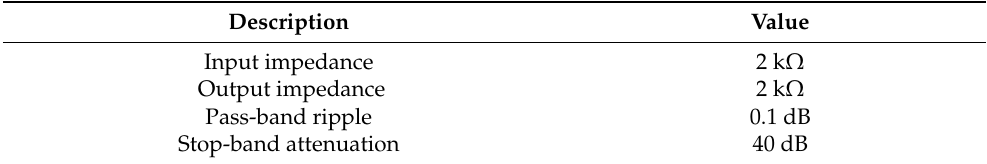
Table 1. Specifications of elliptic low-pass analog